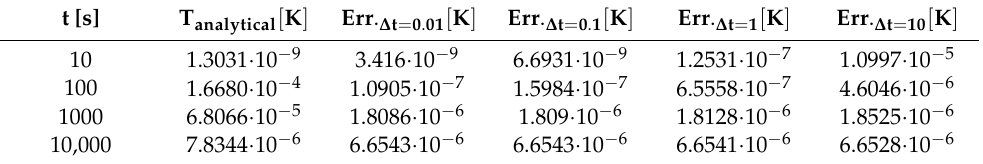
Table 1. Results for the temperature of the reference point obtained by the analytical solution and the corresponding error (Err.) of the simulation results for different time steps and time step increments ( ∆ t ). t [s] T analytical [ K ] Err . ∆ t = 0 . 01 [ K ]